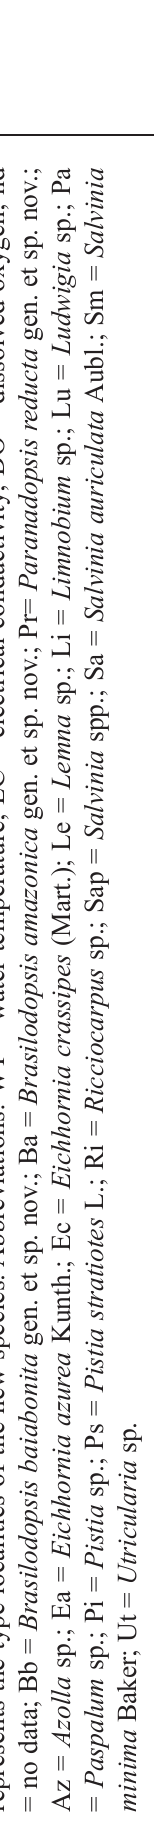
; p . s a ll o z A = z A